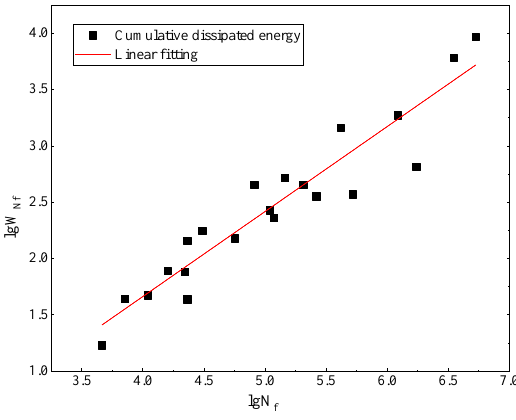
Figure 9. Fitting results.